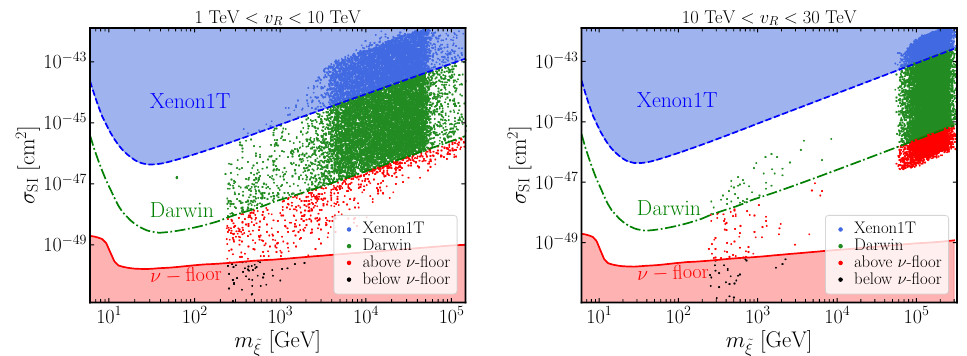
Figure 7. Spin-independent DM-nucleon cross section σ SI versus DM mass m ˜ of our model for the relevant two intervals of right-handed sneutrino VEVs (left panel) 1 TeV < v R < 1 TeV and (right panel) v R > 10 TeV. Blue dots are excluded by the Xenon1T experiment [150]. Green dots will be probed by the upcoming Darwin experiment [151]. Red (black) dots correspond to points above (below) the neutrino floor